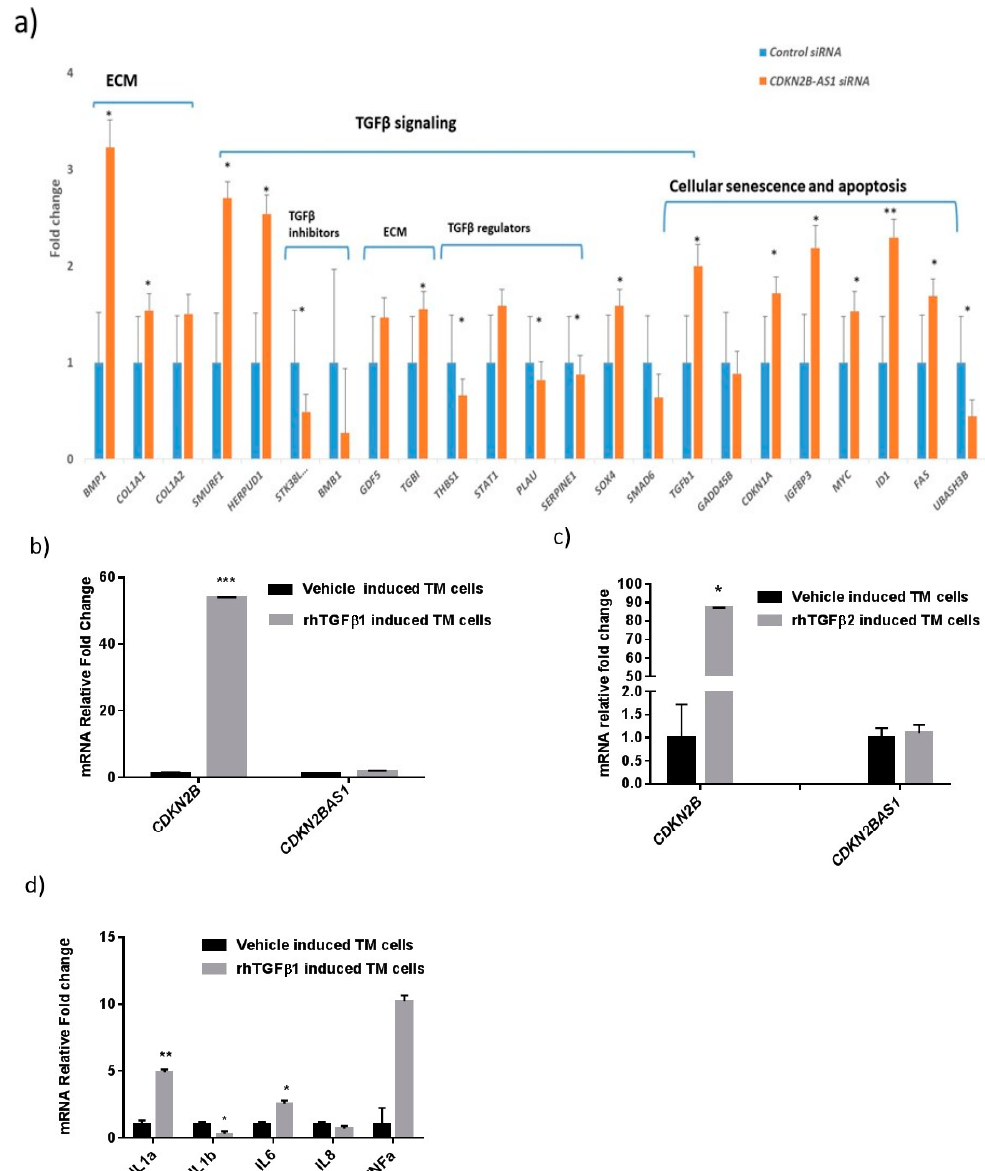
Figure 5. CDKN2B-AS1 mediated senescence and inflammatory cytokine secretion via TGF β signaling. ( a ) The human TGF β BMP Signaling Pathway RT2 Profiler PCR arrays showed di ff erential gene expression profile in TM cells after 10 nM CDKN2B-AS1 siRNA and control siRNA treatment for 72 h. ( b , d ) TM cells were treated with vehicle or 2.0 ng / mL activated rhTGF β 1 for 3 days. ( c ) TM cells were treated with vehicle or 2.0 ng / mL activated rhTGF β 2 for 3 days. β -actin normalized transcript levels for CDKN2B , CDKN2B-AS1 , inflammatory cytokines (IL1a , IL1b , Il6 , IL8 and TNFa) in TGF β induced hTM cells relative to control as detected by qPCR. Bar graphs illustrate fold change (2 − ∆∆ C T ) ± SEM. Asterisks indicate significance of di ff erence from controls; *** p < 0.05, ** p < 0.005, * p < 0.005.